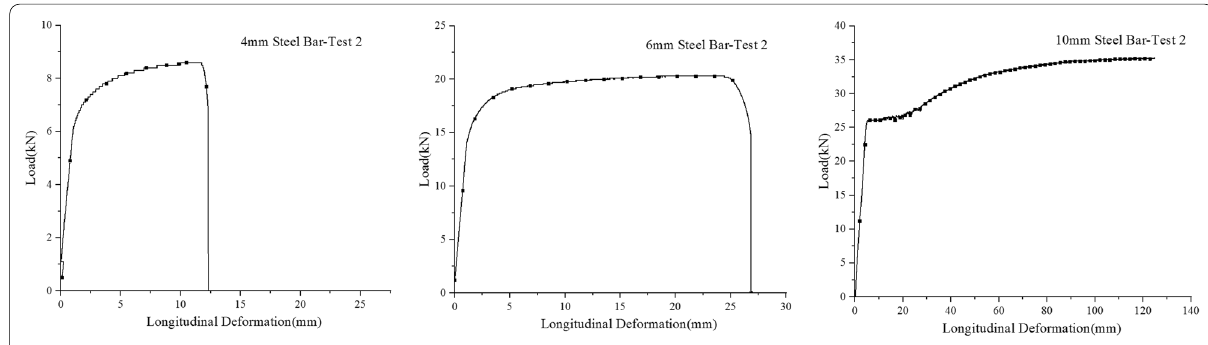
Fig. 5 Strain–stress test curves of steel bars.